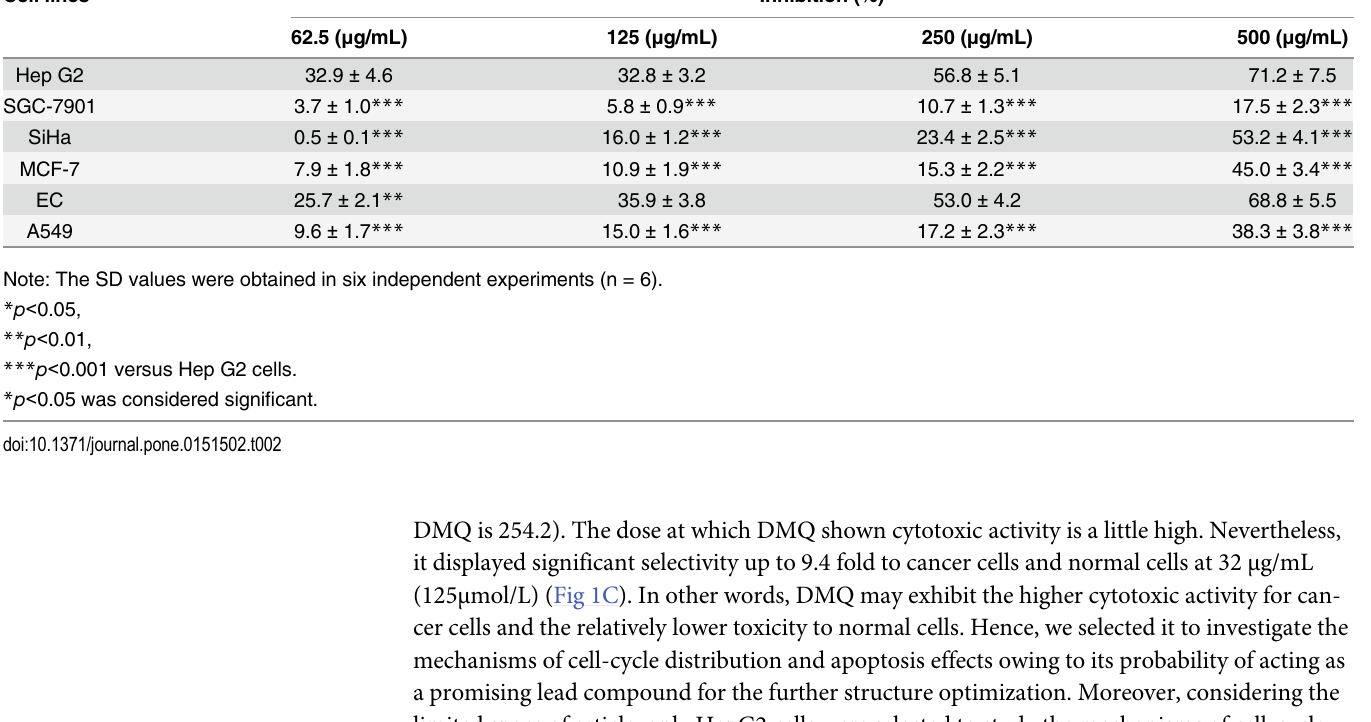
Table 2. In vitro antitumor activity of H-EtOAc fraction against six human tumors (  x  ± SD). Cell